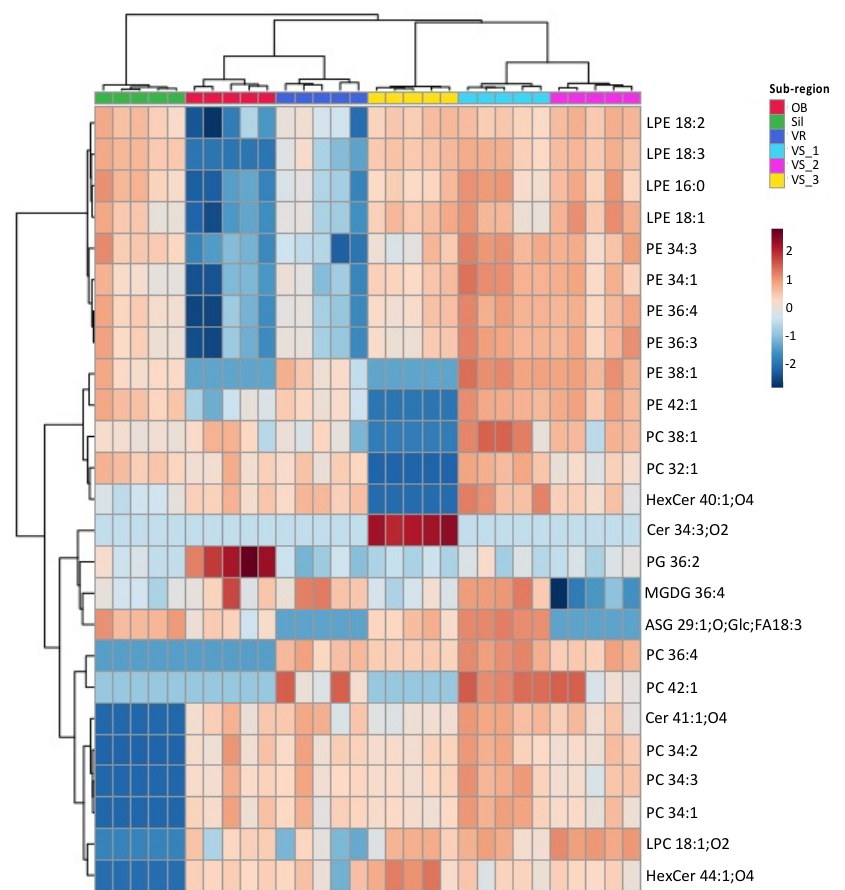
Figure 3. Hierarchical clustering heatmap of the polar lipid species data. Heatmap/clustering of the top 25 polar lipid species with lowest q values (i.e., the polar lipid species with the higher discriminating power). The dendrogram of the top represents the sample groups. The color scale shows the relative abundance levels, i.e., normalized peak areas, and the numbers indicate the fold difference from the mean. Lipid species abbreviation follows the LIPID MAPS nomenclature and shorthand notation, as C ‐ atoms: number of double bond equivalents (DBE) and C ‐ atoms: DBE; O ‐ atoms for oxygenated lipids. Samples were collected in Nelas (Portugal) from six olive orchards located in Vilar Seco_1 (VS_1), Vilar Seco_2 (VS_2), Vilar Seco_3 (VS_3), Silgueiros (Sil), Oliveira de Barreiros (OB), and Vila Ruiva (VR).